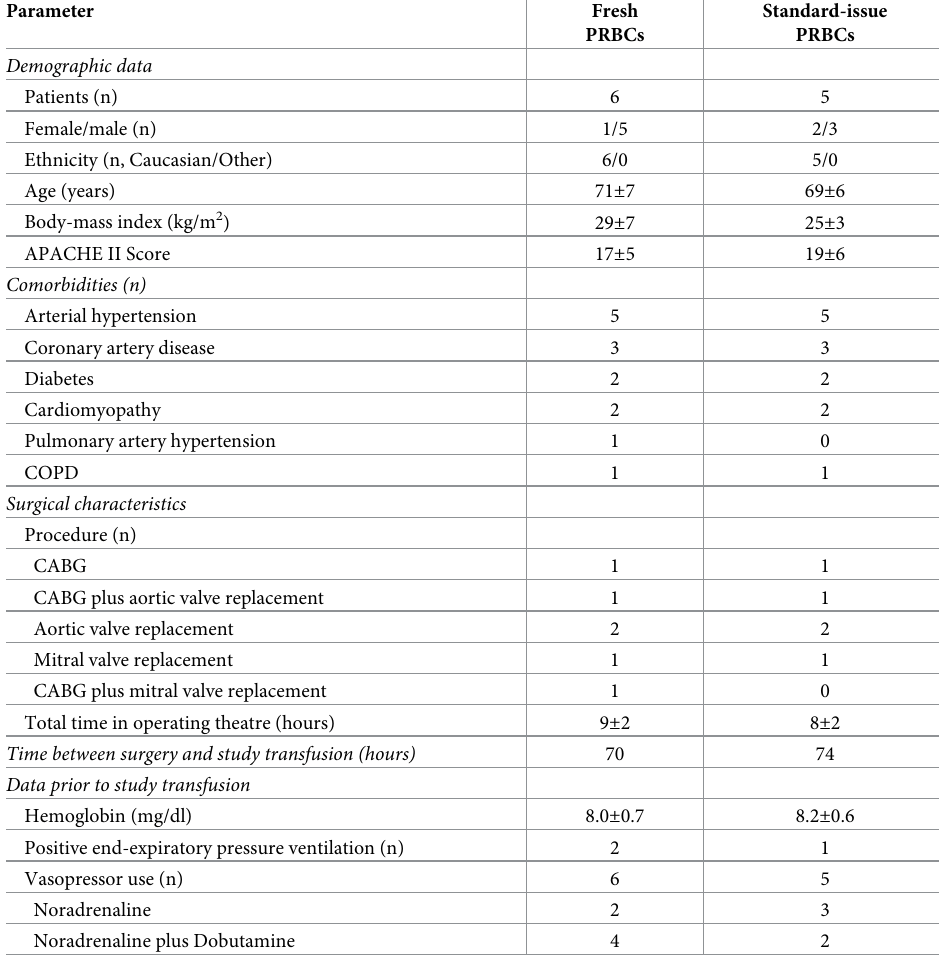
Table 1. Demographic and baseline characteristics of the study population. Data are depicted as absolute numbers or mean ± standard deviation. Abbreviations: APACHE, acute physiology and chronic health evaluation; CABG, coro- nary artery bypass grafting; COPD, chronic obstructive pulmonary disease; PRBCs, packed red blood